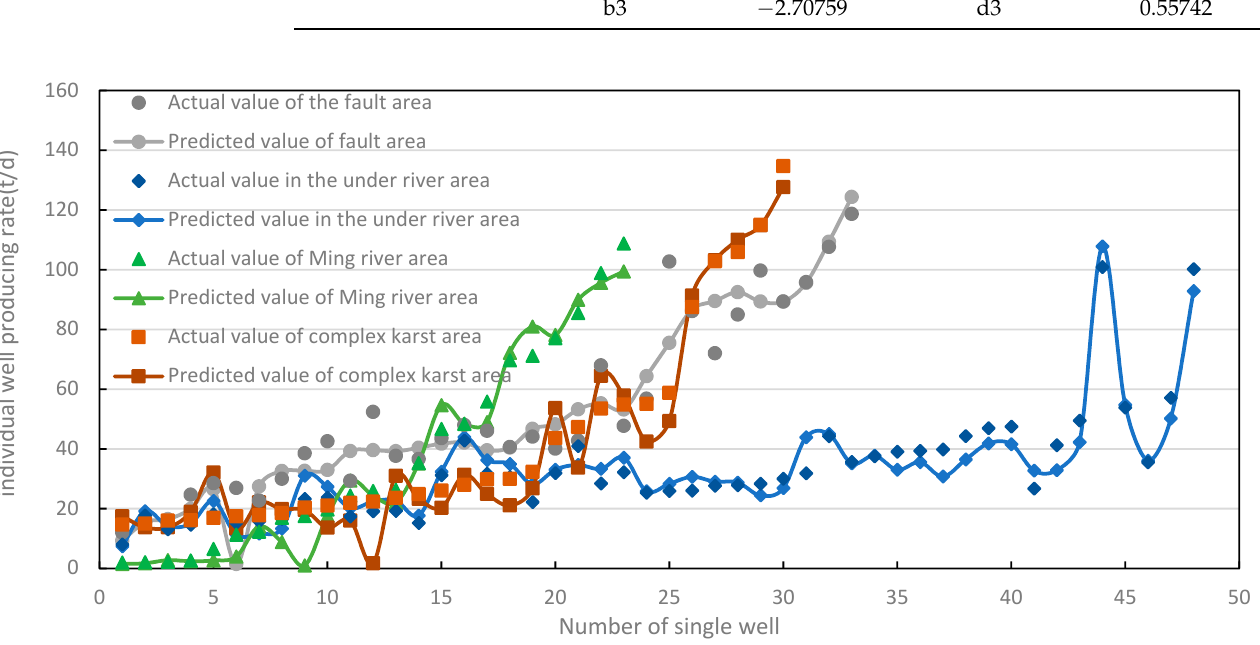
Figure 3. Comparison chart of production forecast. Table 3. Production calculation results.